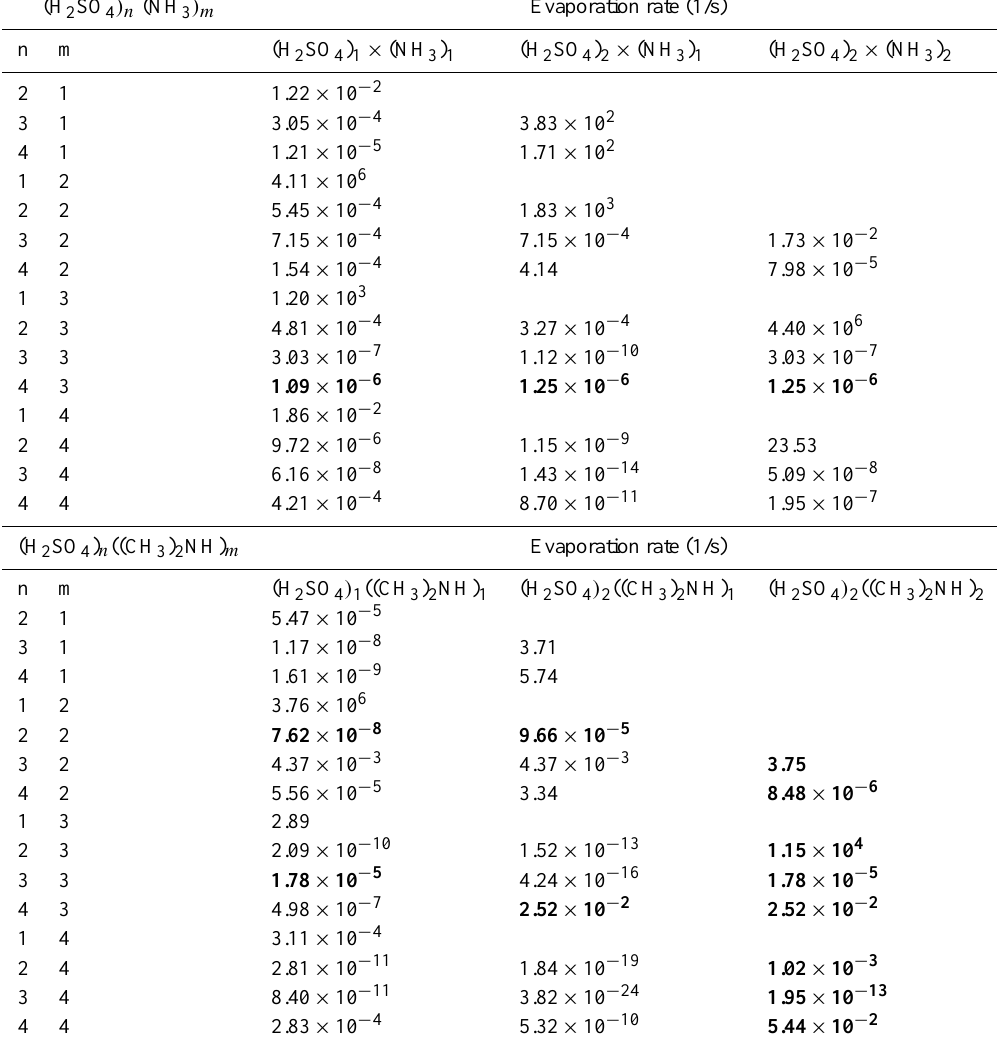
Table S4.2. Non-monomer